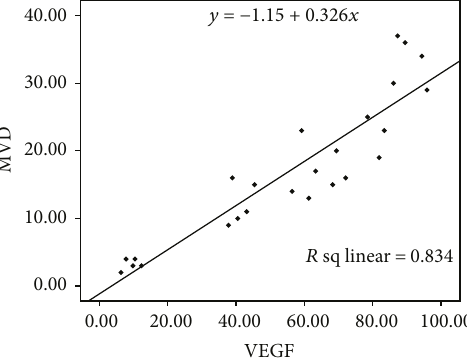
Figure 10: The correlation between VEGF and MVD in hepatoma tissues after di ff erent